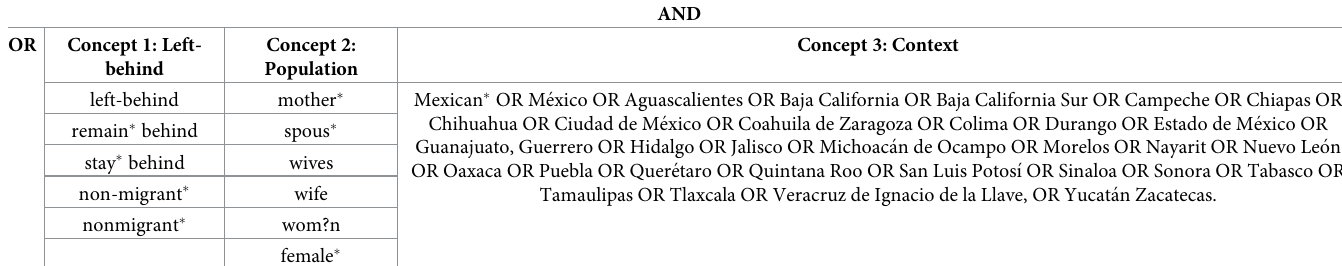
Table 1. Search strategy. Edmonton, AB, Canada,